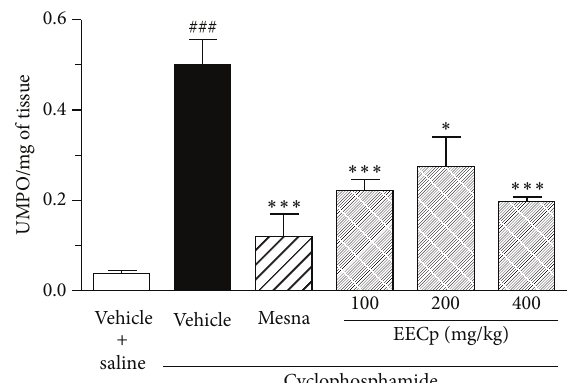
Figure 1: The ethanol extract of Caesalpinia pyramidalis (EECp) decreases the myeloperoxidase (MPO) activity in bladder of rats during cyclophosphamide-induced cystitis. Animals were treated with EECp (100–400 mg/kg, p.o.), vehicle, or mesna (40 mg/kg, i.p.) and injected with cyclophosphamide (200mg/kg, i.p.). After 24 h, the MPO activity was determined in urinary bladder homogenate and was expressed as units (U) of MPO/mg of tissue. ### 𝑃 < 0.001 versus vehicle + saline; ∗ 𝑃 < 0.05 or ∗∗∗ 𝑃 < 0.001 versus vehicle +